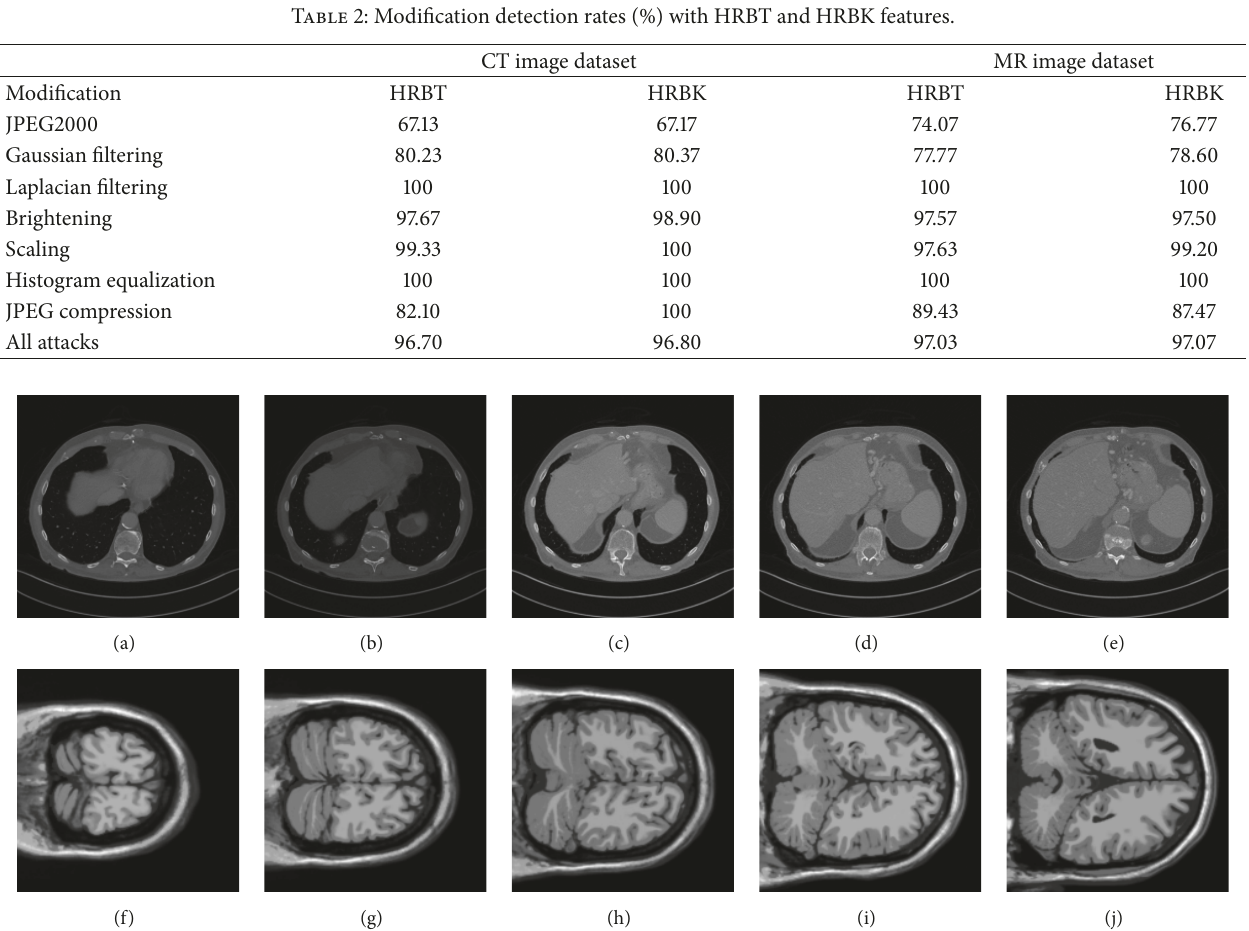
Figure 5: Image samples from our experiments: (a)–(e) CT images, (f)–(i) MR